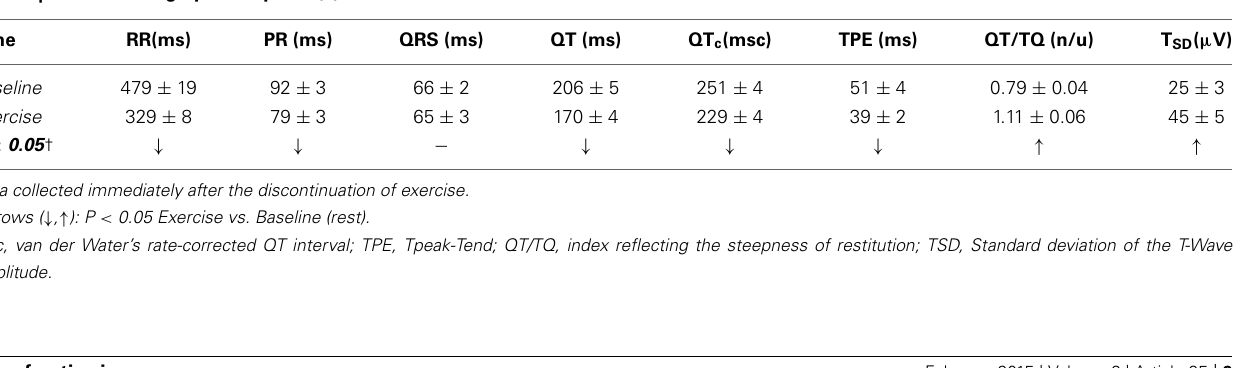
Table 3 | Electrocardiographic response(s) to submaximal